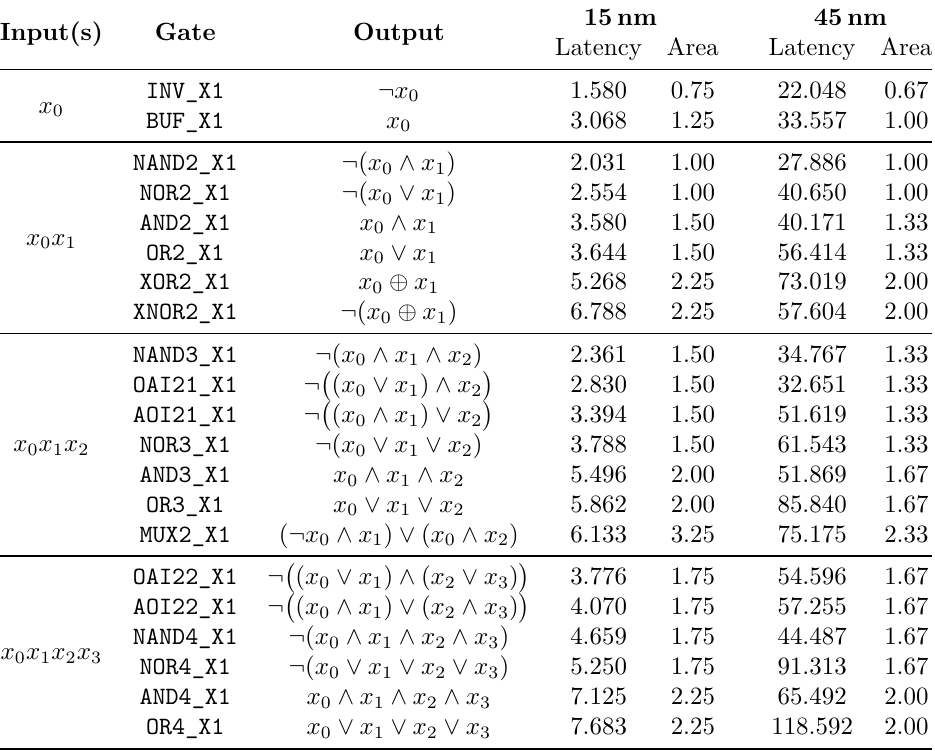
Table 1: The latency (in picoseconds) and the area (in GE) of logic gates (with fan-out number 1) in NanGate 15 nm and 45 nm open cell libraries for typical operating